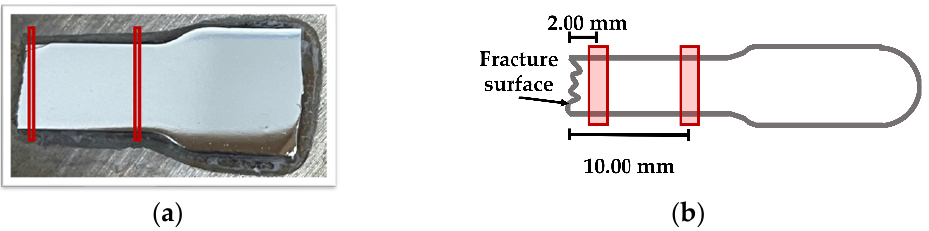
Figure 1. ( a ) Image of the fracture tensile specimen and ( b ) schematic illustration of the sections observed using SEM and EBSD techniques.